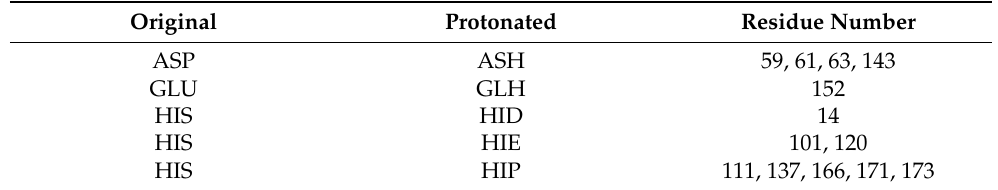
Table A2. shows the change of protonation states at pH 6.5.